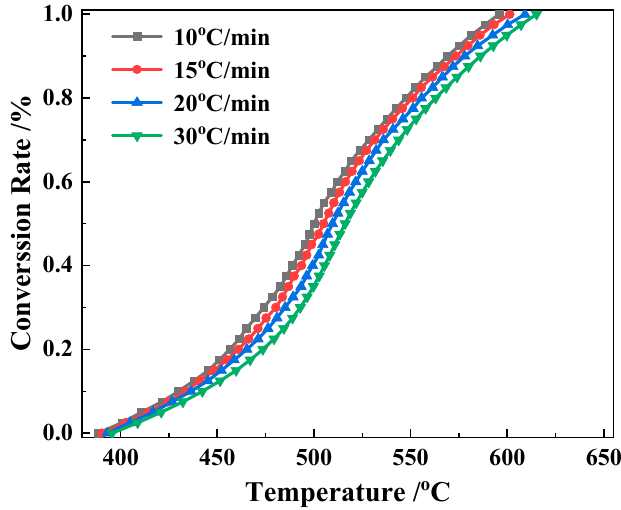
Figure 6. Conversion rate curves.